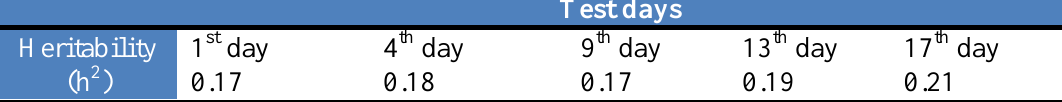
Table 5. heritability estimates for daily buffaloes milk yield (test days)